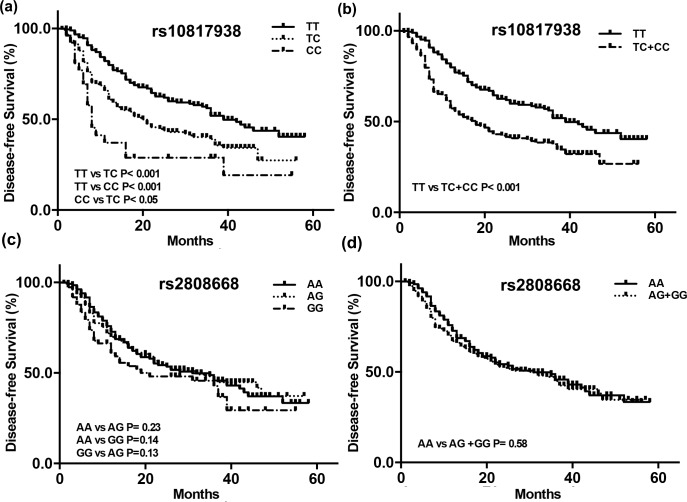
Kaplan-Meir survival curves; Kaplan-Meir survival curves for OSCC patients with rs10817938 (a, b) and rs2808668 (c, d) polymorphisms. The XPA rs10817938 polymorphism was correlated with the disease-free survival in OSCC patient, but not rs2808668.